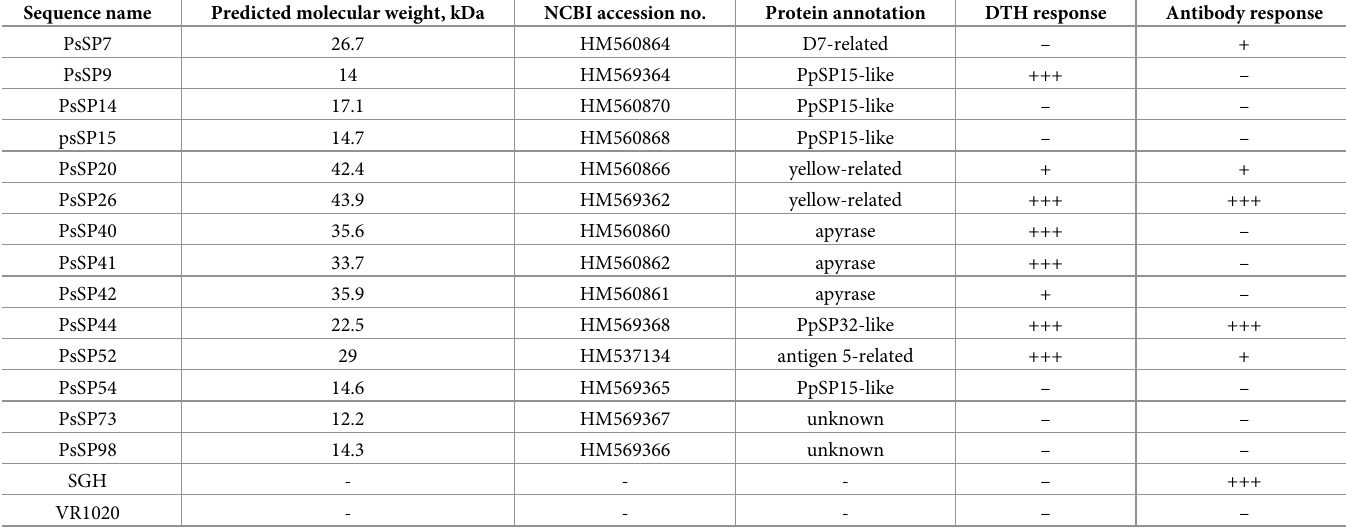
Table 1. The immune response (DTH and antibody) induced in BALB/c mice by immunization with plasmids encoding for the most abundant secretory salivary proteins of Ph . sergenti . Sequence